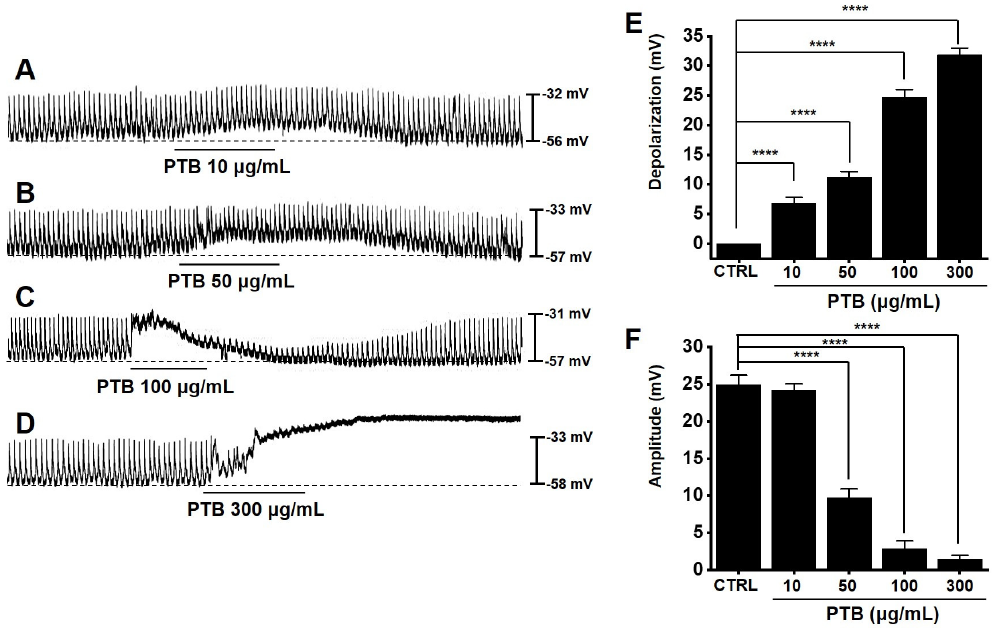
Figure 6. Effects of PTB extract on pacemaker potential of interstitial cells of Cajal (ICCs). ( A – D ) PTB extract depolarized the ICC pacemaker potentials. ( E , F ) The changes in pacemaker potential and amplitude induced by PTB extract are summarized. Means ± SEs. **** p < 0.0001. PTB: Pinellia ternate Breitenbach. CTRL: control.